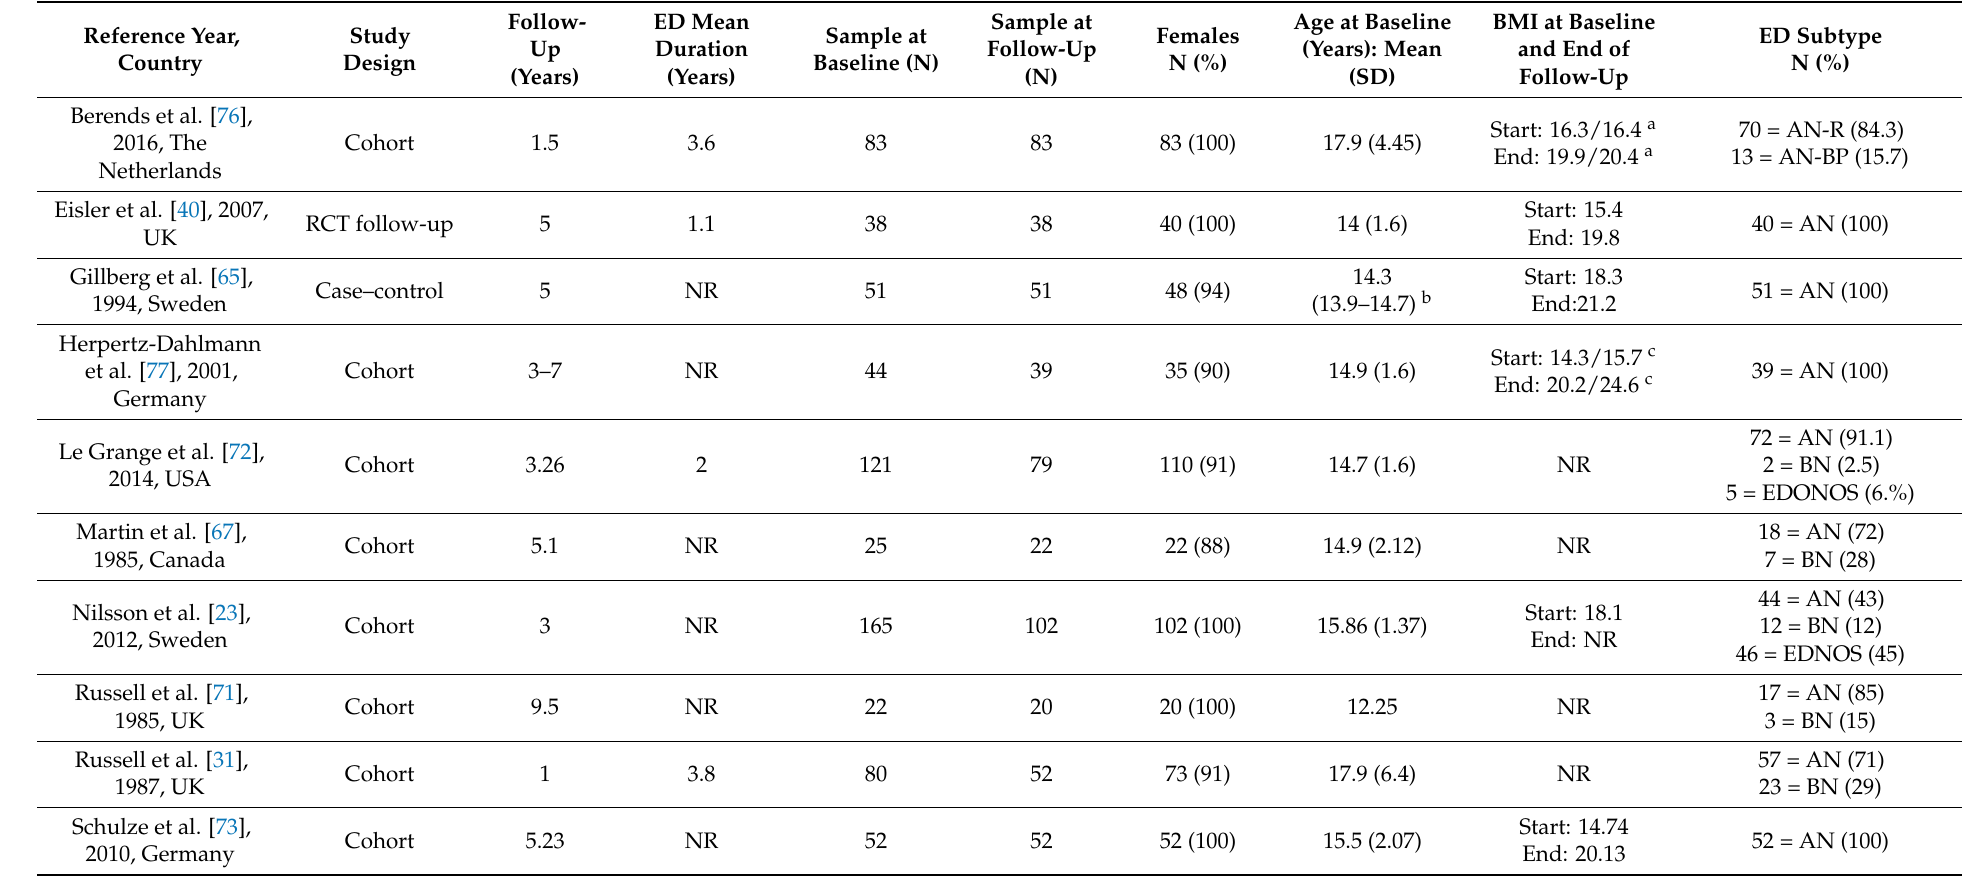
Table 1. Characteristics of population samples in the included